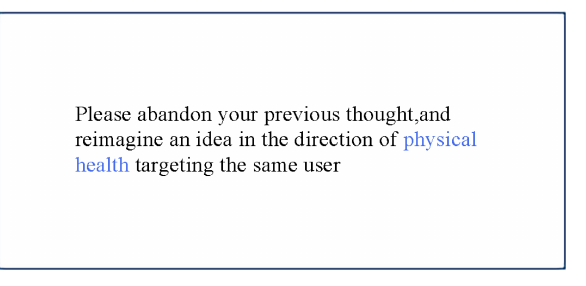
FIGURE 2 | Task information for